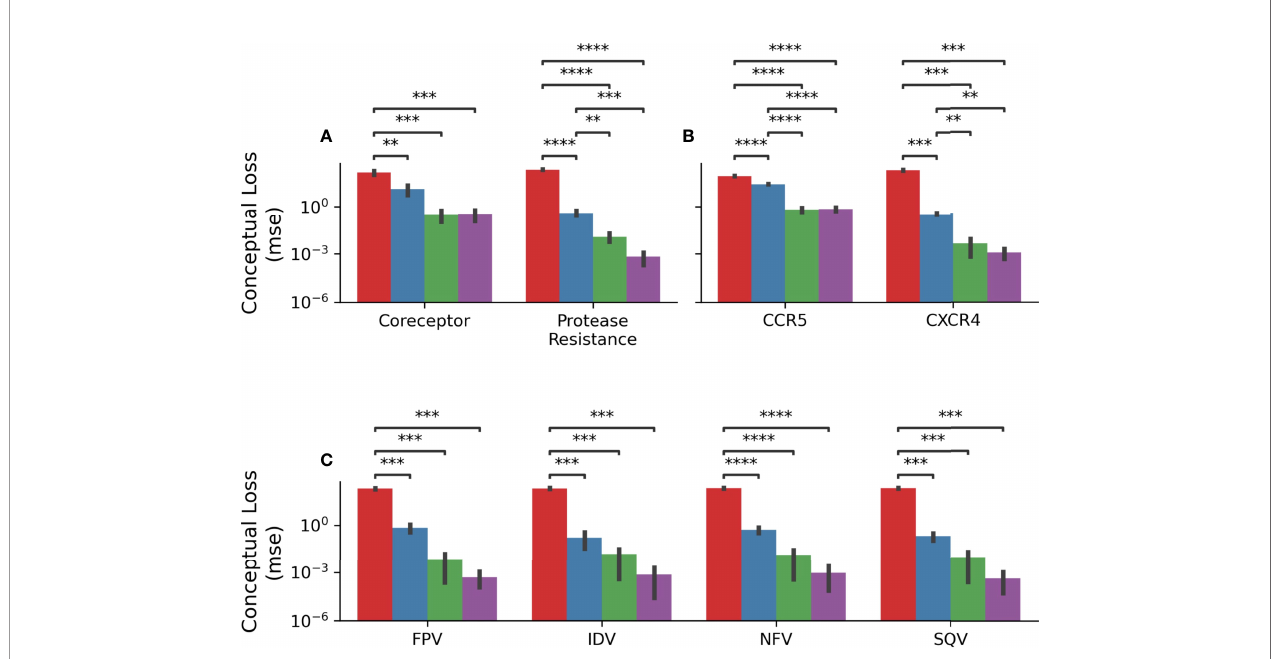
FIGURE 8 | HIV-1 pretraining decreases conceptual error. (A) The average conceptual error of each model is shown across the coreceptor and protease resistance tasks for each model. (B) The conceptual error was disambiguated across each fi eld of the coreceptor model. (C) The conceptual error was disambiguated across each fi eld of the protease resistance model. Across all axes the Null model is shown in red, the TF-IDF model is shown in blue, the Prot-BERT model shown in green and the HIV-BERT model shown in purple. The test-comparison bars represent the results of a paired t-test between each group; undrawn comparisons p<0.05, *(0.05<p<=0.01), **(0.01<p<=0.001), ***(0.001<p<=0.0001), ****(p<=0.00001). A Bonferroni correction based on all possible tests in the fi